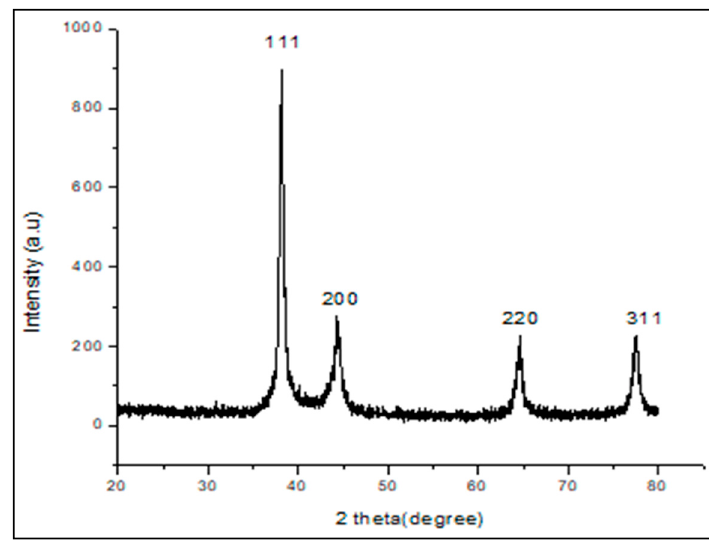
Figure 3. X-ray diffraction (XRD) analysis of green-synthesized AuNPs.